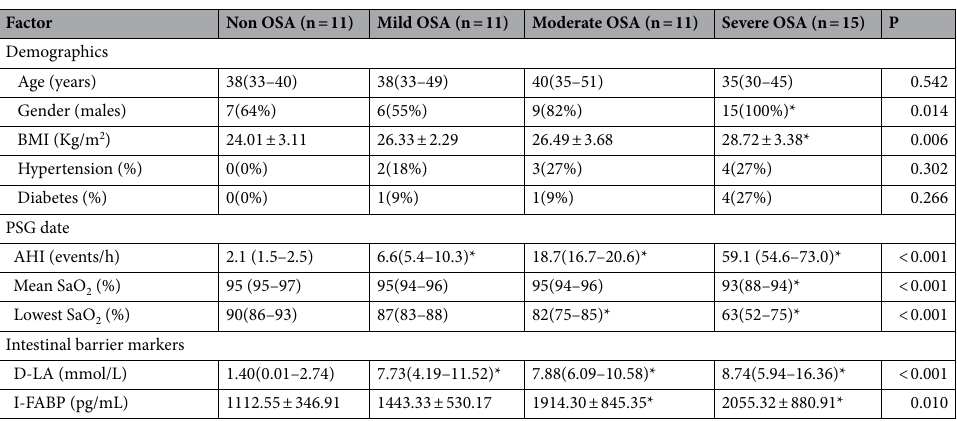
Table 1. Baseline characteristics and intestinal barrier markers of participants. BMI, body mass index; AHI, apnea–hypopnea index; SaO 2 , pulse oxygen saturation; D-LA, D-lactic acid; I-FABP, intestinal fatty acid- binding protein. values are expressed as mean ± standard deviation, median (interquartile range) or number (percentage). p values based on Kruskal–Wallis or Chi-Squared (Fisher’s Exact Test) or ANOVA test. *p values significant for the comparison of OSA groups versus No OSA